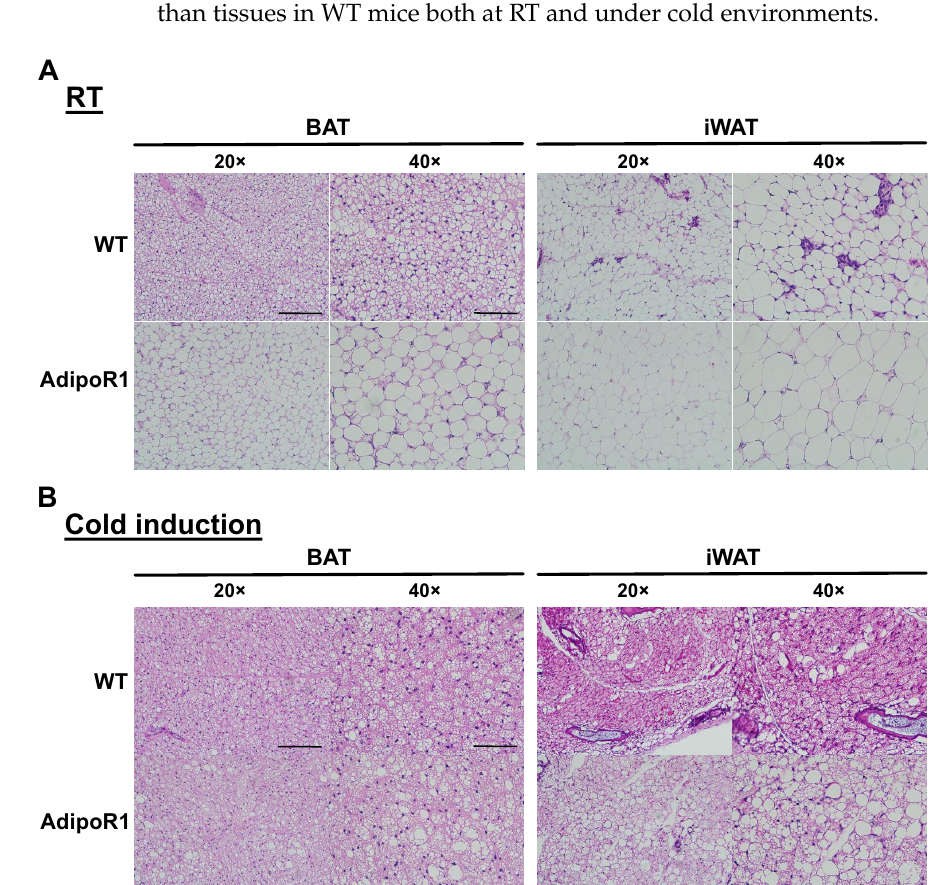
Figure 3. Increased adipocyte size in classical brown and beige adipose depots of AdipoR1 mice. Cold-acclimated WT and transgenic AdipoR1 mice were evaluated for the morphology of brown and beige adipose tissues. Timeline and procedures were described in Figure 1. Classical iBAT and iWAT (the potential white adipose depot for browning or beiging) in WT and AdipoR1 female mice ( A ) at room temperature or ( B ) in cold environments were harvested, fixed, sectioned, and evaluated for histology by hematoxylin and eosin (H&E) staining. Scale bar: 100 µ m for 20 × , 50 µ m for 40 ×